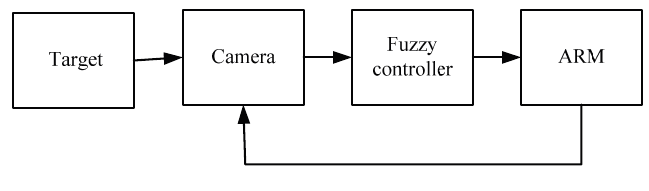
Figure 23. Position control scheme with fuzzy controller.